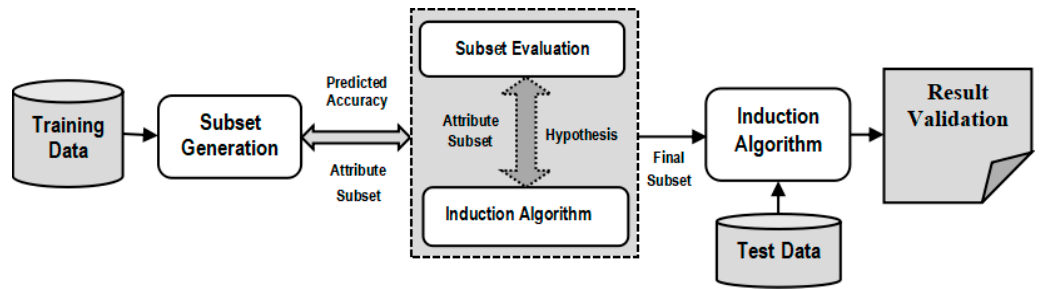
Figure 2. Wrapper Approach for Attribute Selection.